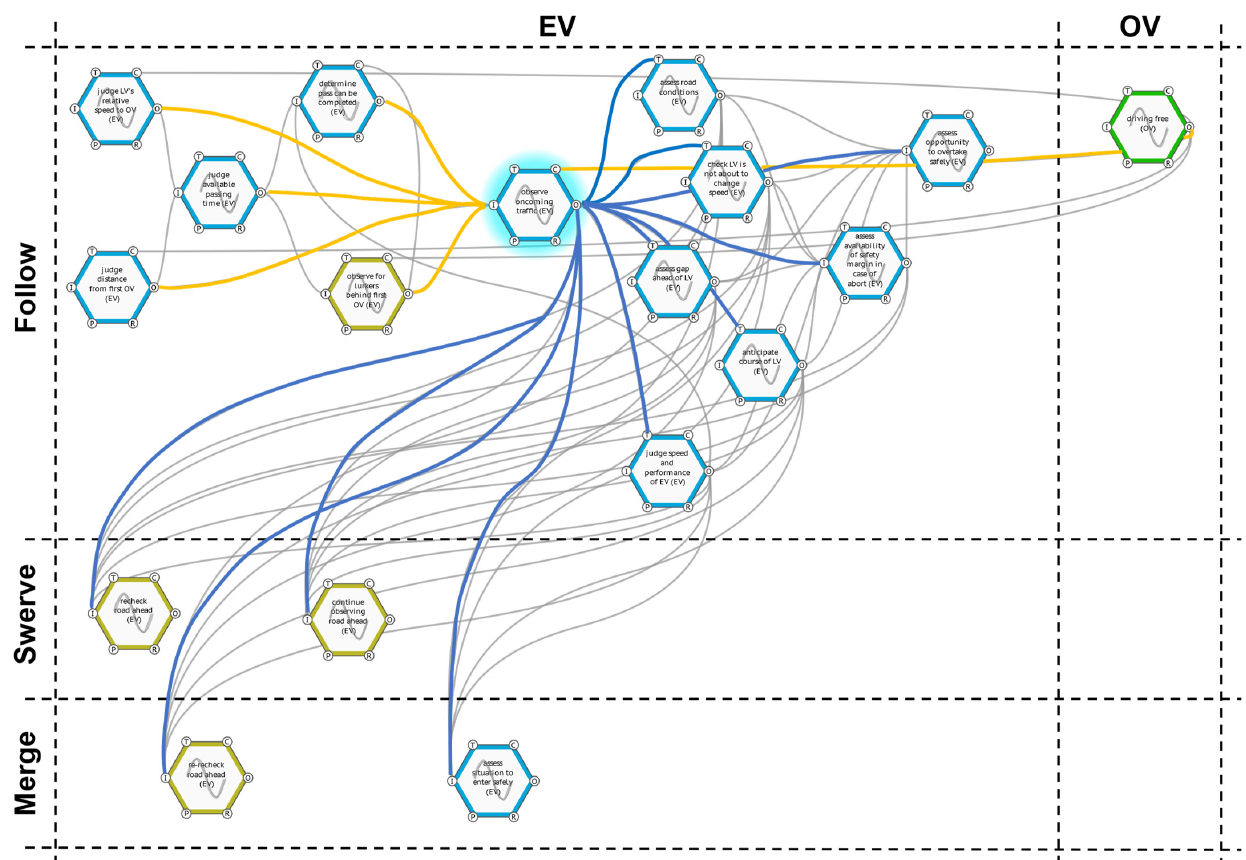
Figure 14. The critical path of the function < observe oncoming traffic (EV) > for the automation.